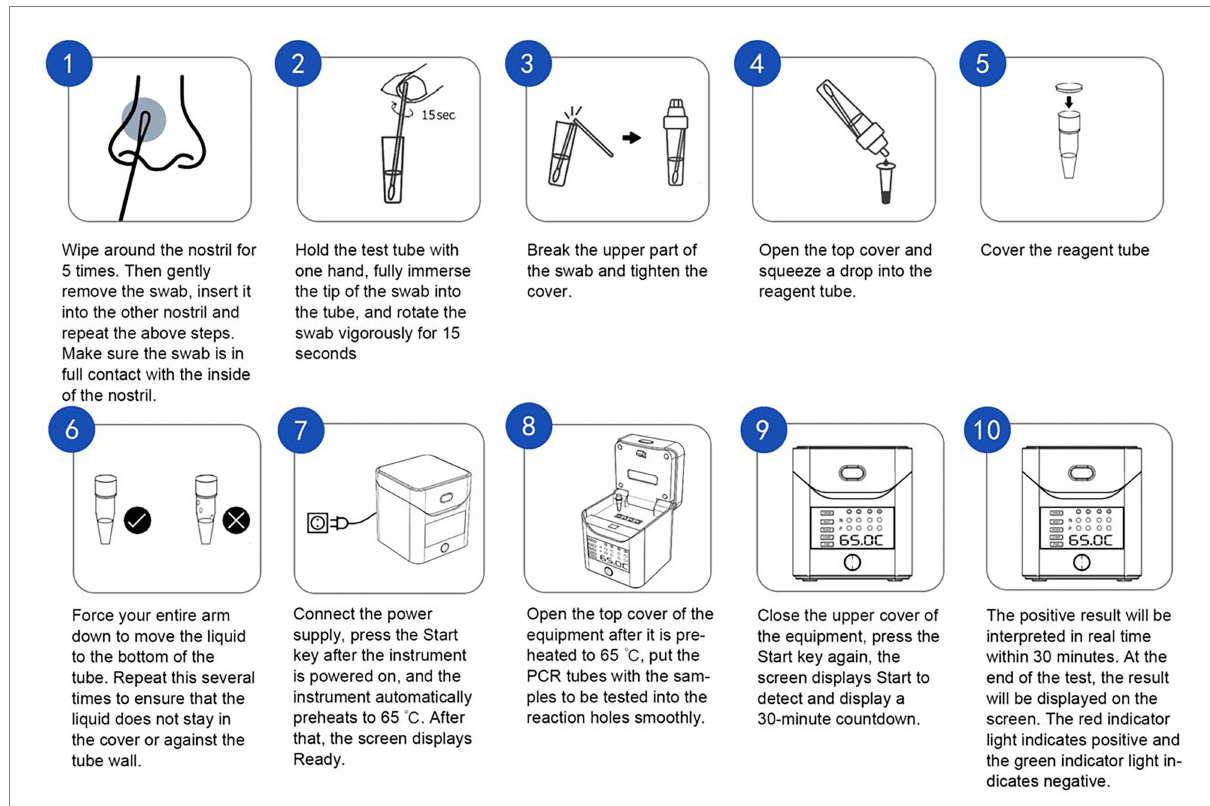
FIGURE 1 Operation flow of the LAMP